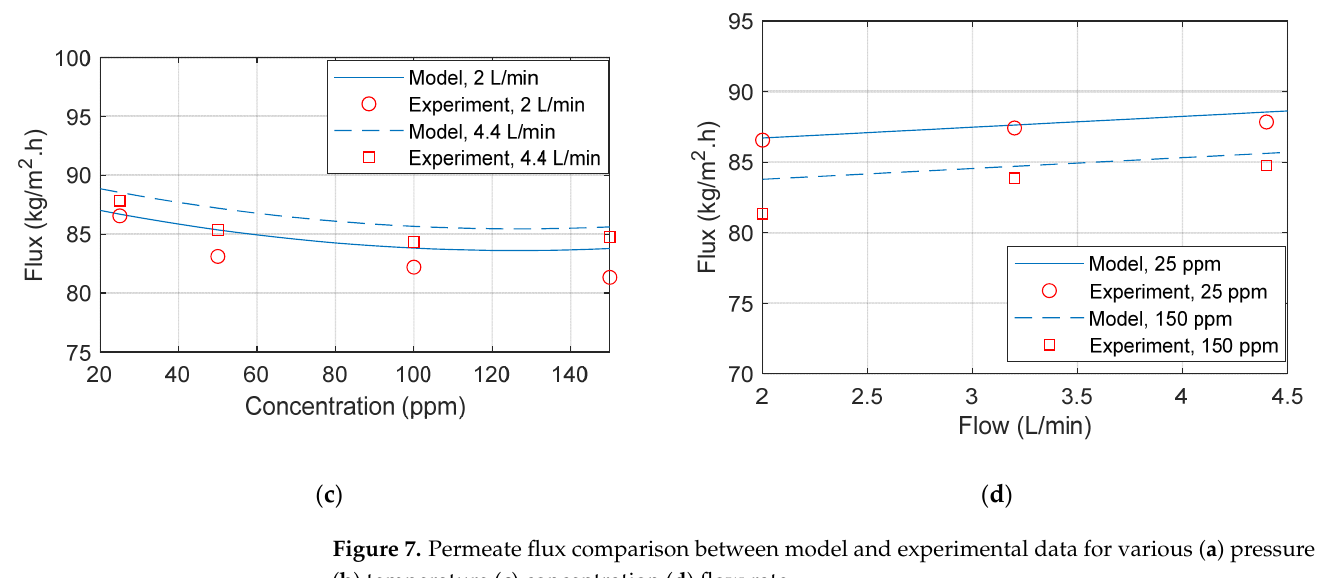
Figure 7. Permeate flux comparison between model and experimental data for various ( a ) pressure ( b ) temperature ( c ) concentration ( d ) flow rate.